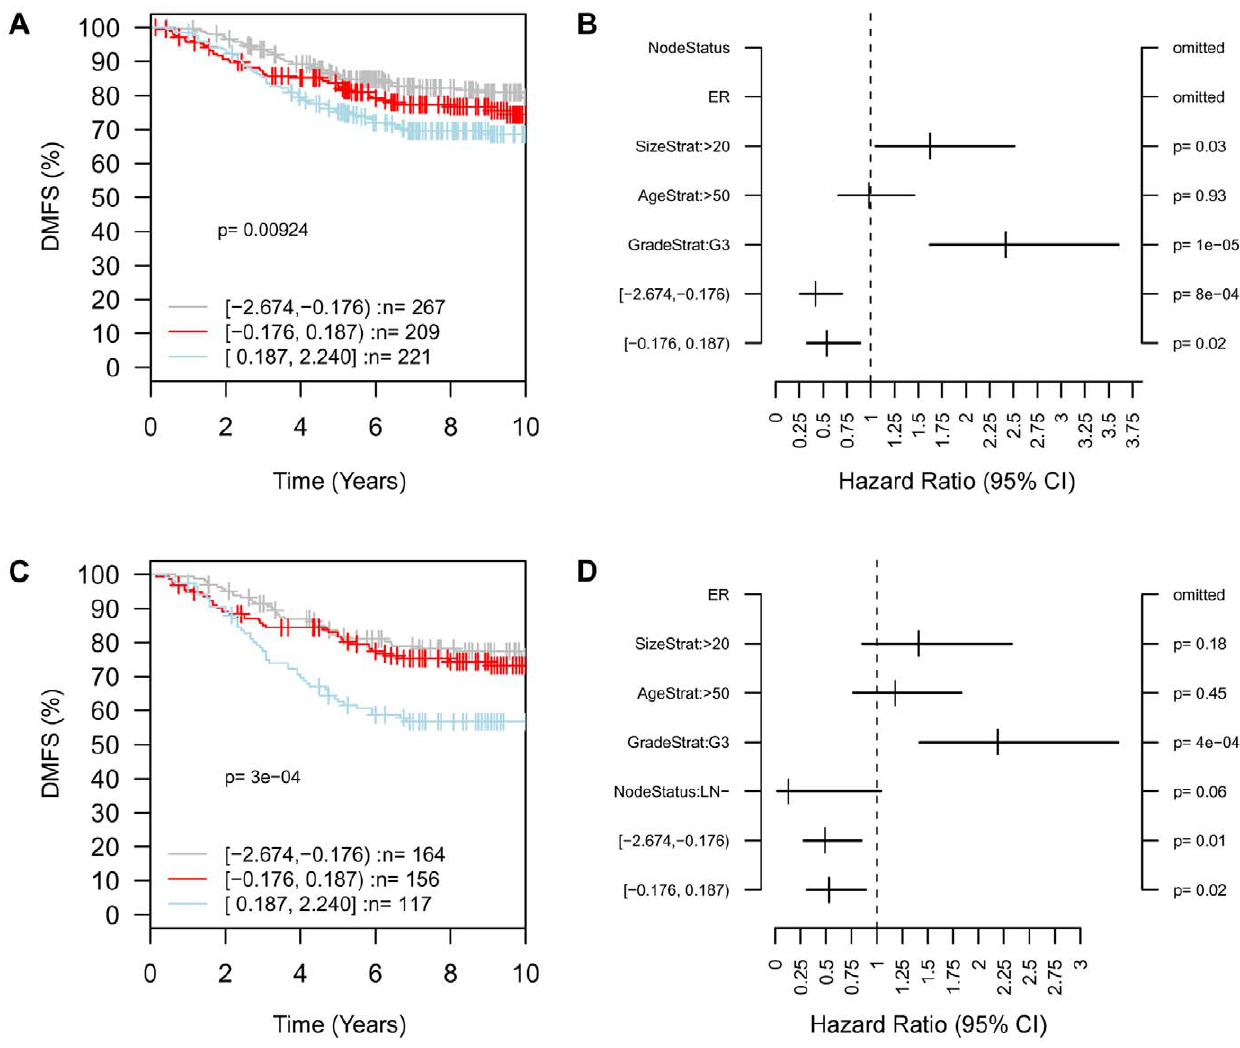
Figure 8. High expression of ARID4B is associated with poor clinical outcome. In patients with ER-positive tumors who were node negative at diagnosis (A) distant metastasis-free survival (DMFS) was significantly lower (p=.009) in patients with high expression (blue) compared to middle (red) or low (gray) expression of ARID4B , and multivariate analysis of 440 cases (B) was performed to determine metastatic progression hazard ratios of 0.54 and 0.42 for median and low ARID4B terciles, respectively, compared to the high ARID4B tercile. The association of high ARID4B with poor DMFS was also highly significant (p=3.05 6 10 ‘ 2 4) among ER-positive patients in the absence of adjuvant therapy (C) with similar hazard ratios (D) of 0.53 and 0.49 for middle and low ARID4B groups compared to high ARID4B